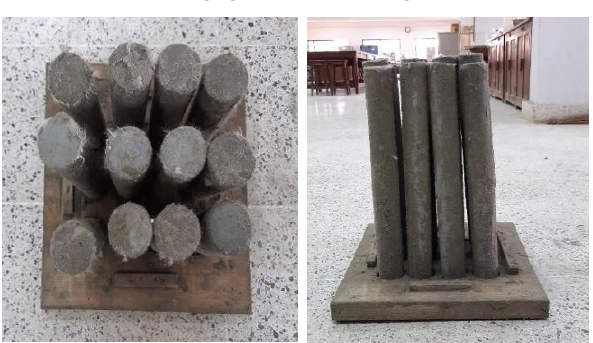
Fig. 13. Penetration of structure inside the soil was negligible after shaking